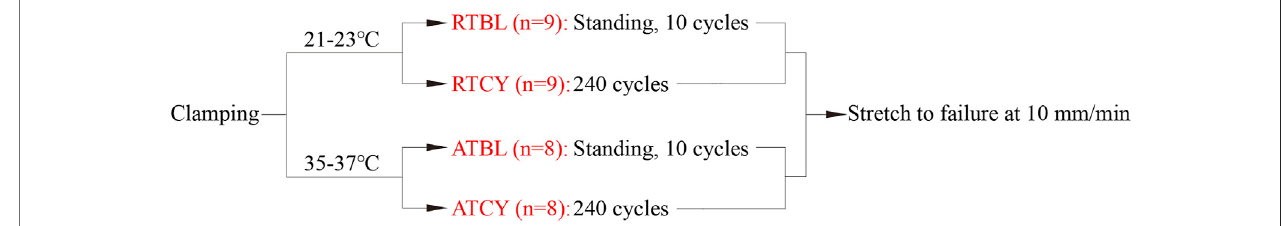
FIGURE2| Testprotocolsofthefourgroups.Oncetheambienttemperaturereachedtheirrespectivespeci fi edvalues,240cyclesofcyclicloadingwereappliedto the samples of the RTCY and ATCY groups. The samples of the RTBL and ATBL groups were stood in the same temperature environment for the same time as the samples ofthe RTCY and ATCY groups, respectively, to keep the same temperature balancetime; then, 10 cycles of cyclic loading were applied. After cyclic loading, all samples were stretched to failure at 10 mm/min.